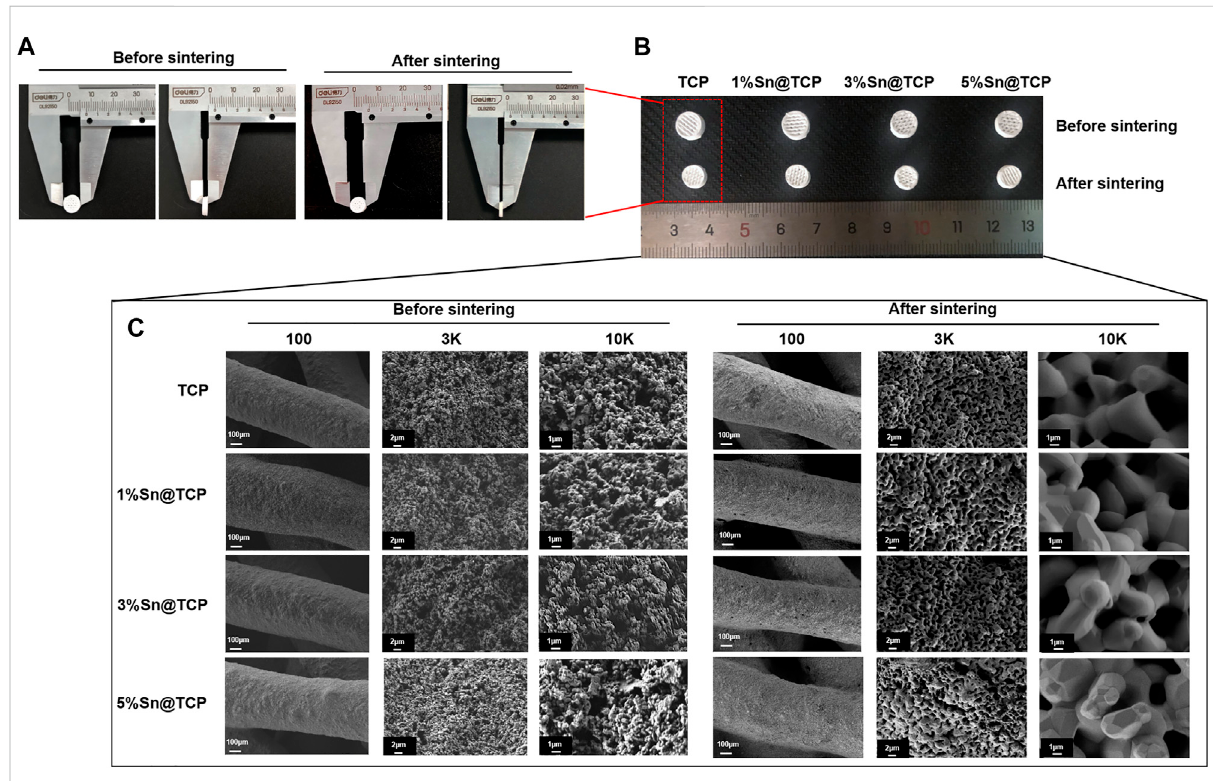
FIGURE 2 Morphologyandstructureof β -TCP(TCP)andSn@TCPscaffolds. (A – B) Thediameterandheightofscaffoldsbeforeandaftersintering. (C)